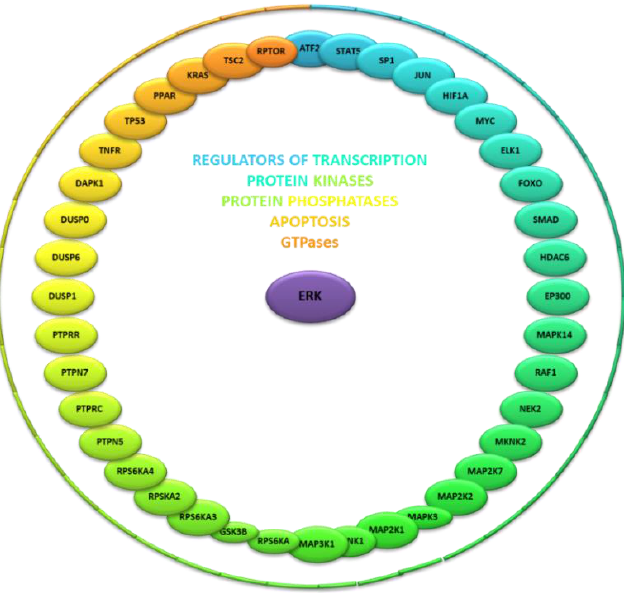
Figure 1. Extracellular signal-regulated kinase (ERK) protein interactors and processes regulated by these